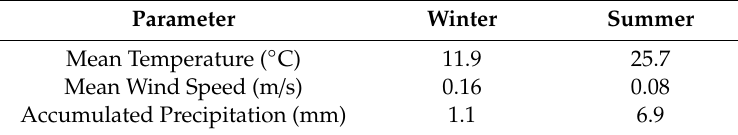
Table A1. Weather conditions near the study site during